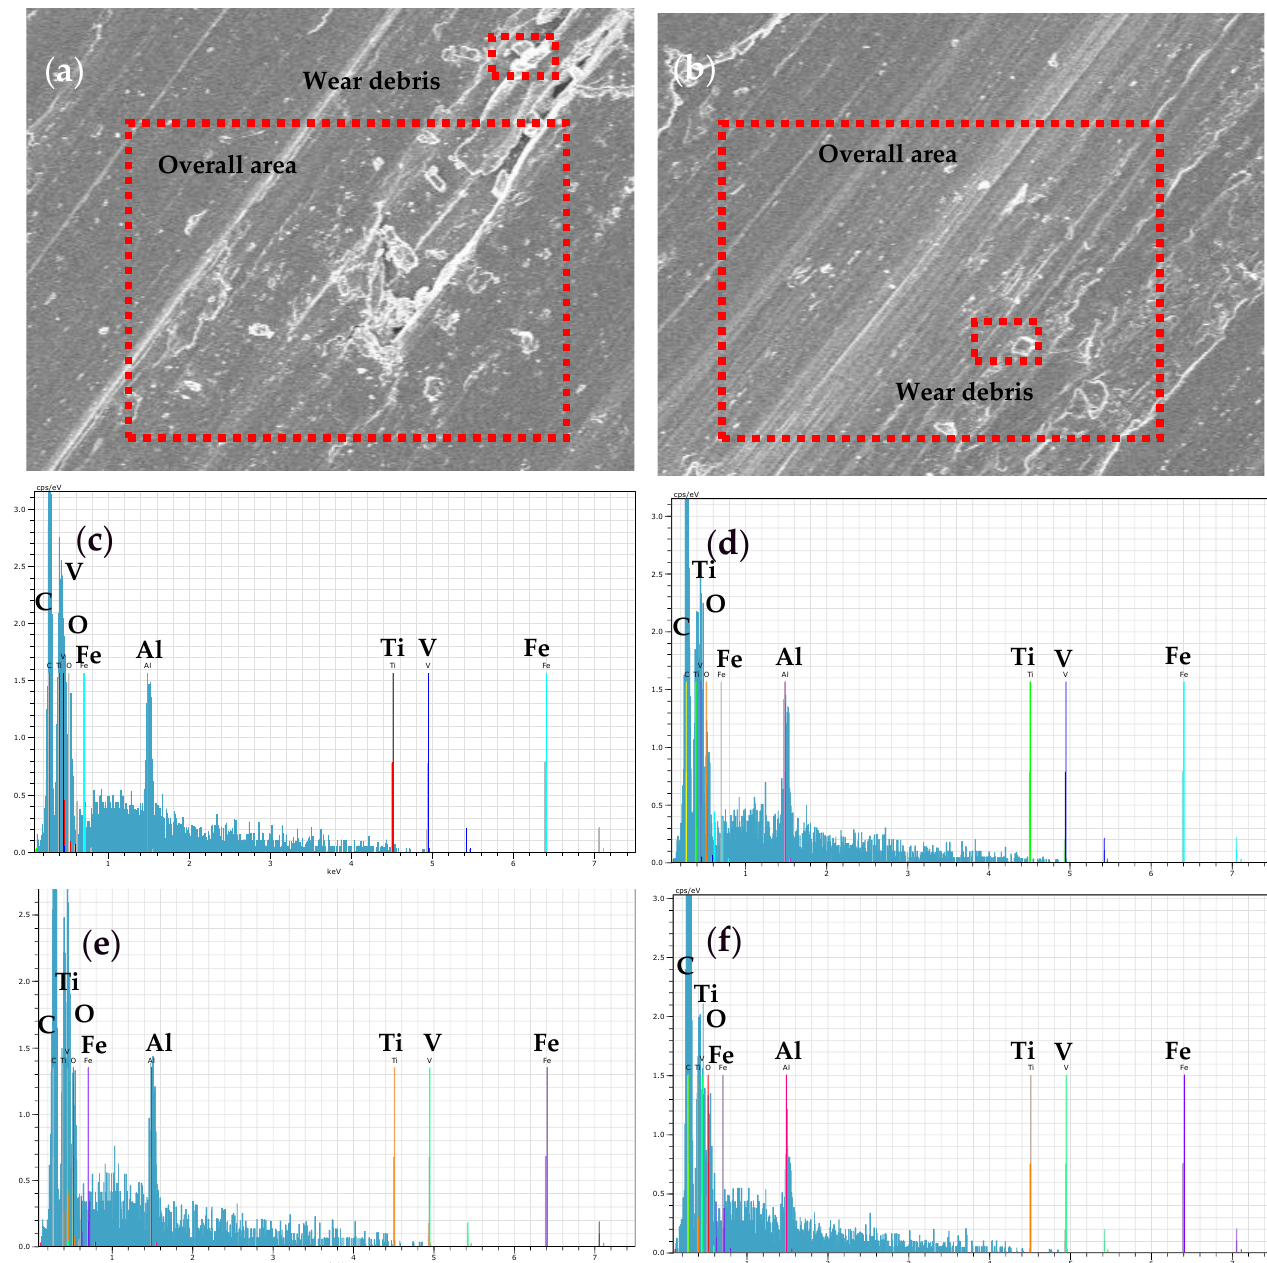
Figure 9. EDS analysis on worn out surface: ( a , b ) micrograph of CACF and SLM specimens and their corresponding overall area scanning elemental graphs ( c , d ), respectively. ( e , f ) Wear debris elemental analysis of CACF and SLM specimens, respectively.